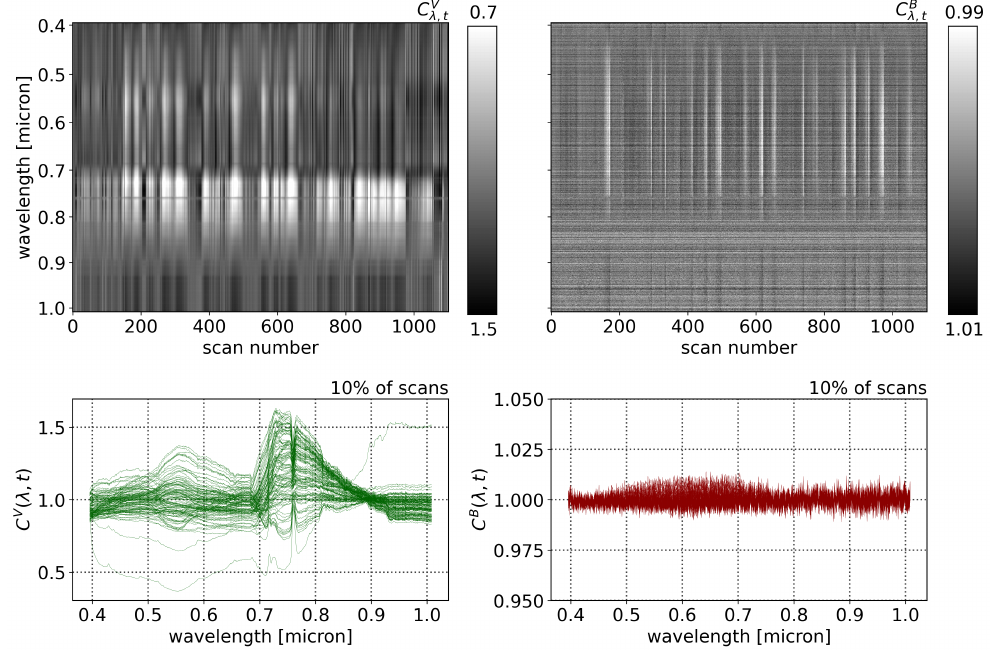
Figure 3. ( Top ): Compound Ratios of all scans for vegetation ( left ) and building ( right ) pixels as functions of wavelength and scan number (i.e., time). ( Bottom ): Compound Ratio of 10% of scans from Figure 3 for vegetation pixels ( left ) and building pixels ( right ) as a function of wavelength. Note that vegetation reflectances are varying at ∼ 50% relative to a set of nearby building pixels, while the building pixels are only varying at ∼ 1% relative to each